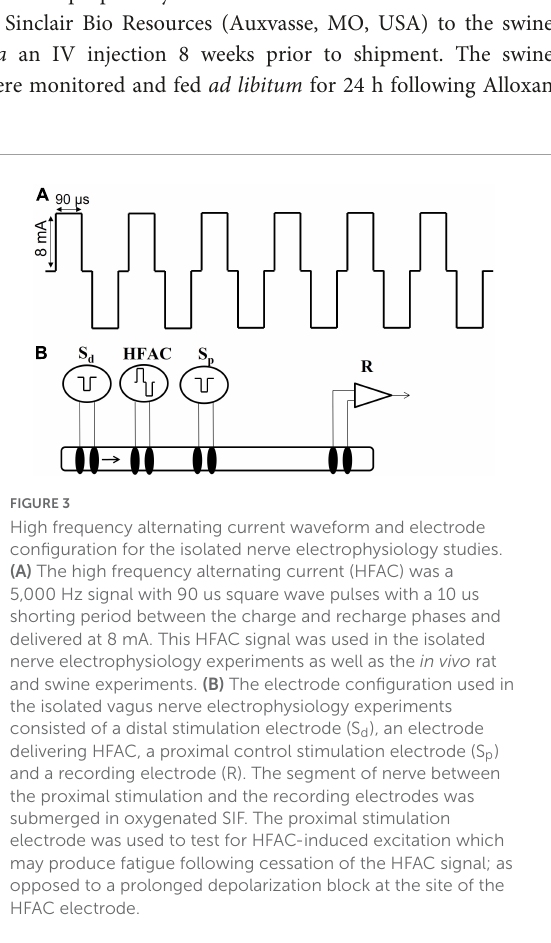
generated by a grass s44 stimulator (Grass Medical Instruments, Quincy, MA, USA) which drove a stimulus isolation unit (Model A360, World Precision Instruments, Sarasota, FL, USA) at 1 Hz.